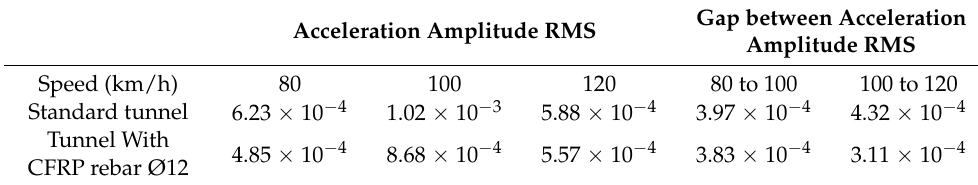
Table 6. Acceleration amplitude RMS at point